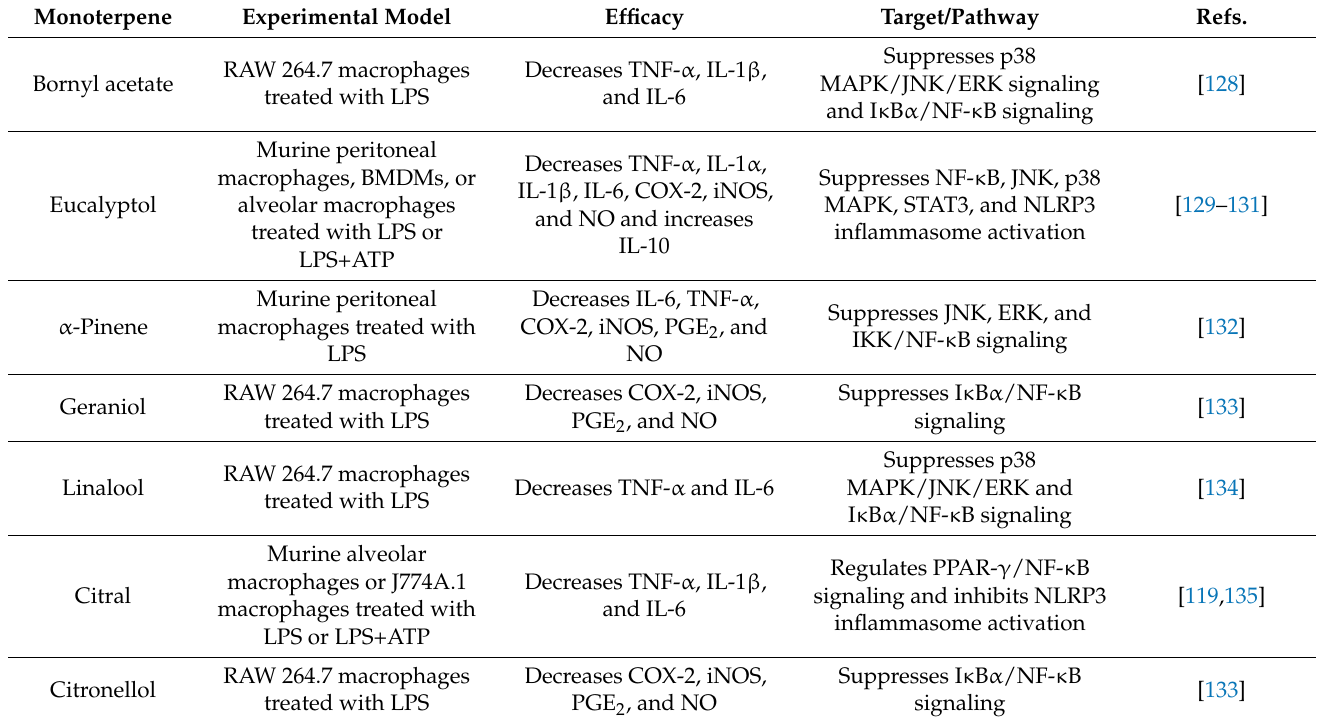
Table 5. Reduction of macrophage-related